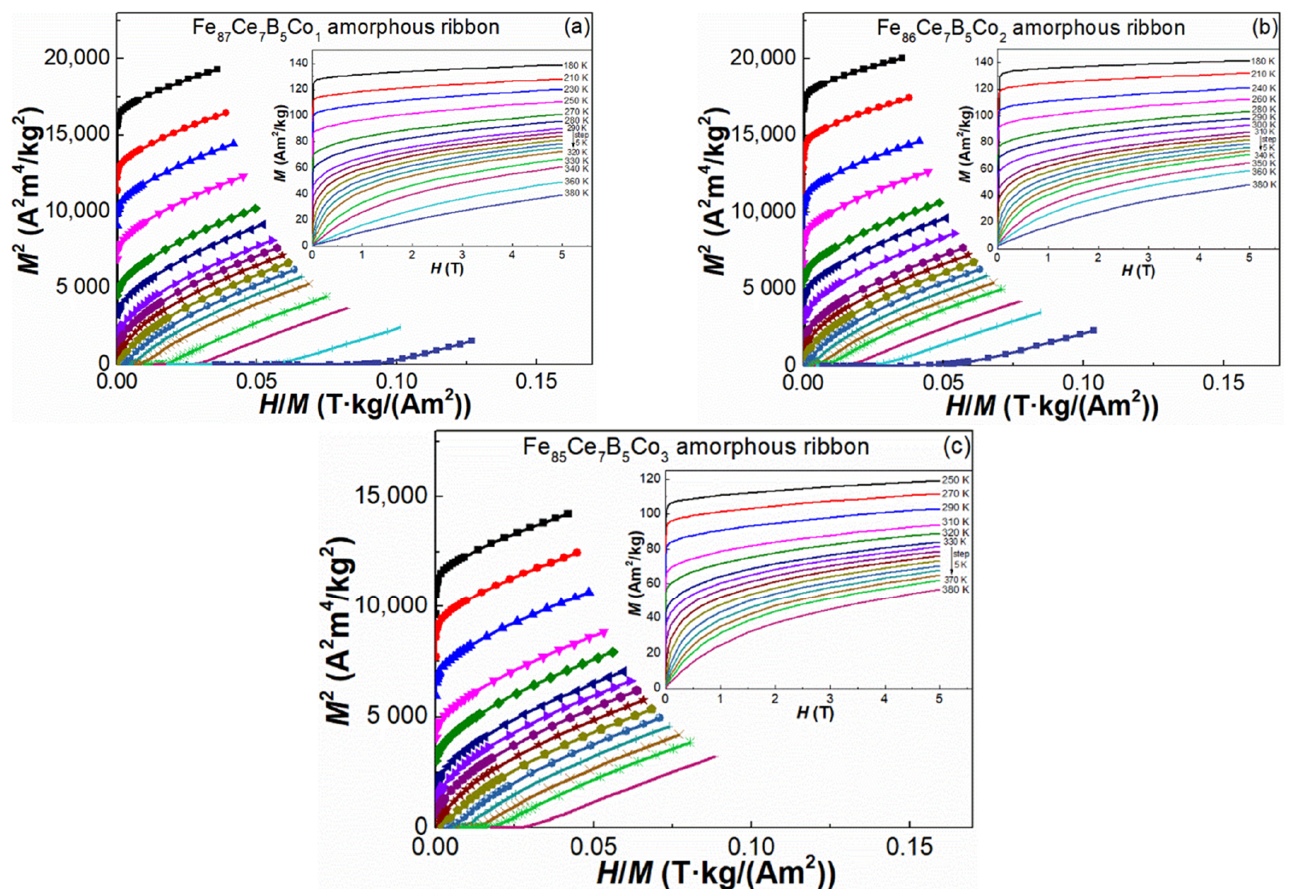
Figure 3. The Arrott plots of the Fe 88- x Ce 7 B 5 Co x amorphous ribbons: ( a ) x = 1, ( b ) x = 2, and ( c ) x = 3, the insets are the isothermal magnetization curves of these ribbons under 5 T.